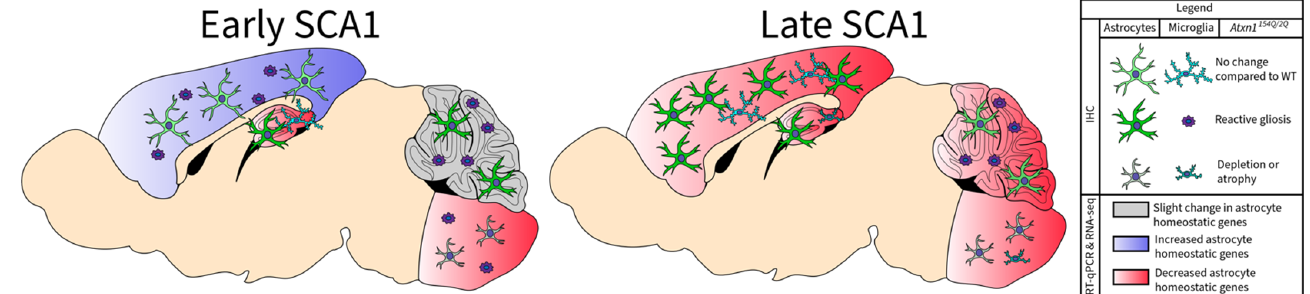
Figure 7. Simplified schematics of astrocytic changes in SCA1. Simplified schematic of astrocytic and microglia changes in SCA1. In early stages of SCA1 (left), brain regions exhibit an increase (cortex) or slight change (cerebellum) in the expression of astrocyte homeostatic genes, whereas regions in red exhibit loss of astrocyte homeostatic genes (hippocampus and medulla). Areas differ in patterns of reactive astrocytes, showing astrocyte atrophy (inferior olivary nucleus (ION)), hypertrophy (cerebellum), or no significant change relative to WT controls (hippocampus and cortex). Most brain regions (cerebellum, ION, cortex) show reactive microglia during early stages of SCA1. During late stages of SCA1 (right), all brain regions exhibit reduced expression of core genes necessary for astrocyte homeostatic function (cortex, cerebellum, hippocampus, and medulla). Most brain regions (cerebellum, hippocampus, and cortex) show reactive astrocytes during late stage of SCA1, although the ION continues to show significant reduction or atrophy of astrocytes. Reactive microglia persist in the cerebellum but are no longer present in the cortex in late SCA1. Some brain regions also show significantly fewer microglia (hippocampus and ION) relative to WT in late